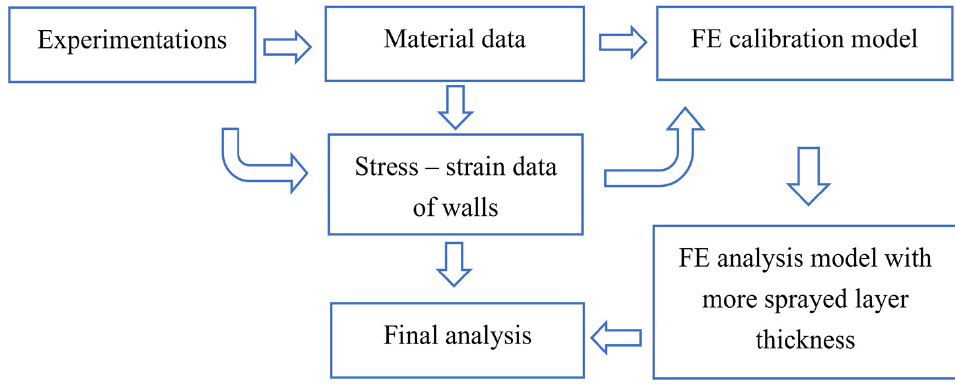
Figure 1. Masonry samples and spraying process.